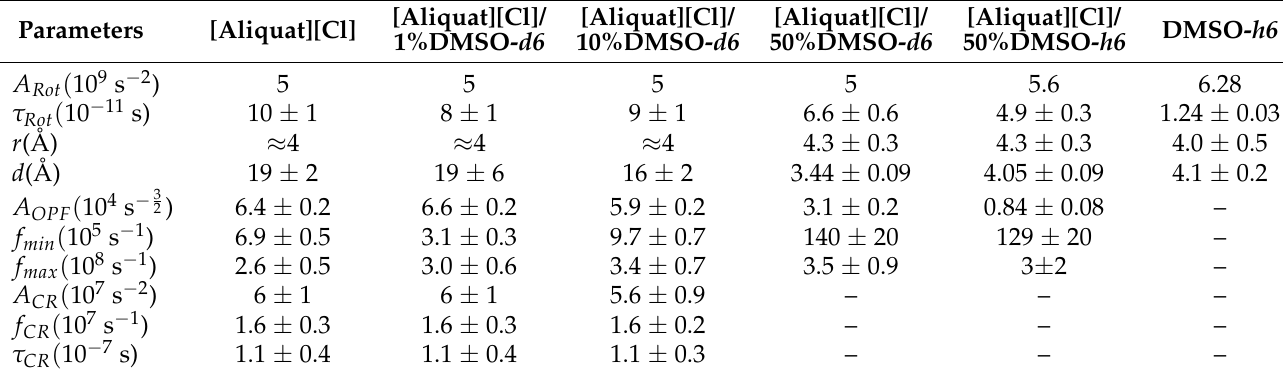
Table 4. Parameters obtained from the NMRD fitting of the non-paramagnetic samples at 25 ◦ C. Uncertainties were estimated by probing the sensitivity of the fit to each individual parameter. The 1 H spin density, n , needed for the Torrey model was fixed to the value presented in Table 1, and the diffusion coefficient, D , was set equal to the average diffusion contribution presented in Table